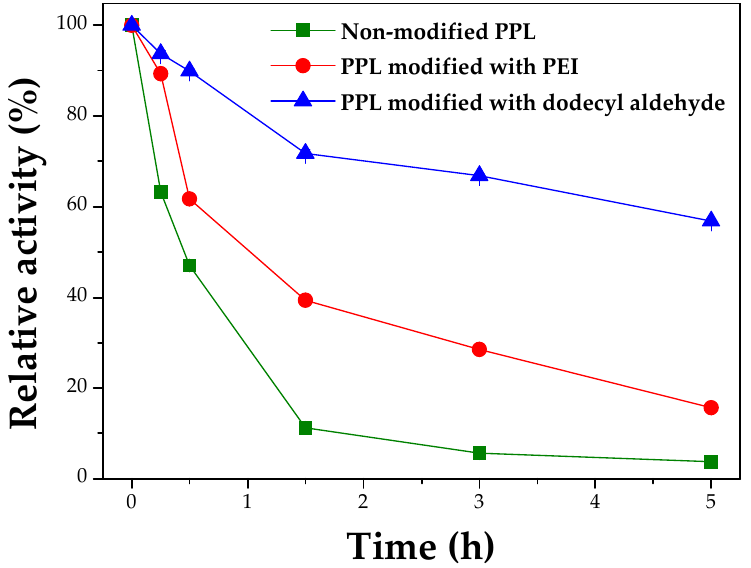
Figure 4. Thermal inactivation of free PPL non-modified and modified with polyethyleneimine (PEI) and dodecyl aldehyde. Assay conditions: 40 °C and pH 8.0 (100 mM phosphate buffer) and enzyme solutions containing 5 mg protein/mL.